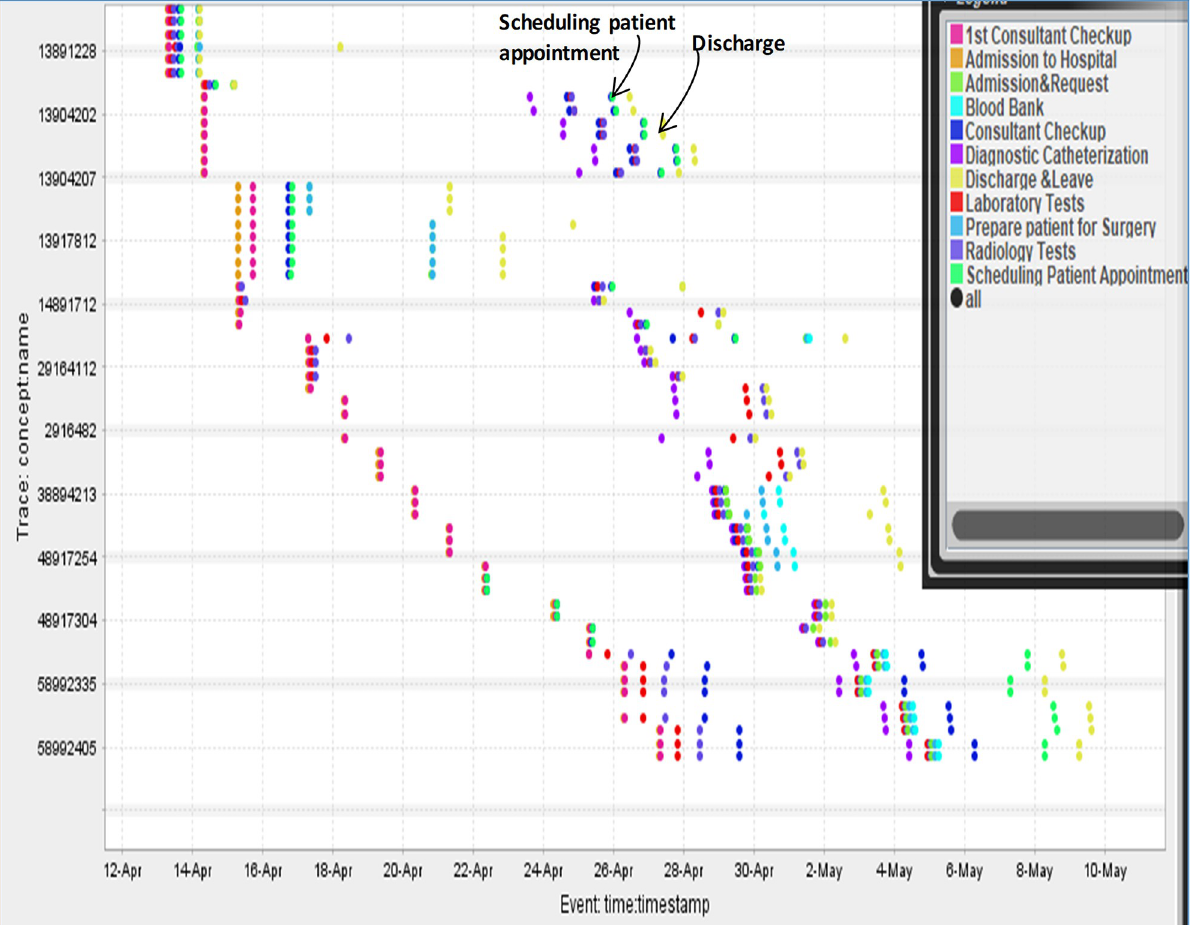
Fig 26. The dotted chart of cluster 3 of “the patients leaved the hospital without any surgery but only took medication care”.